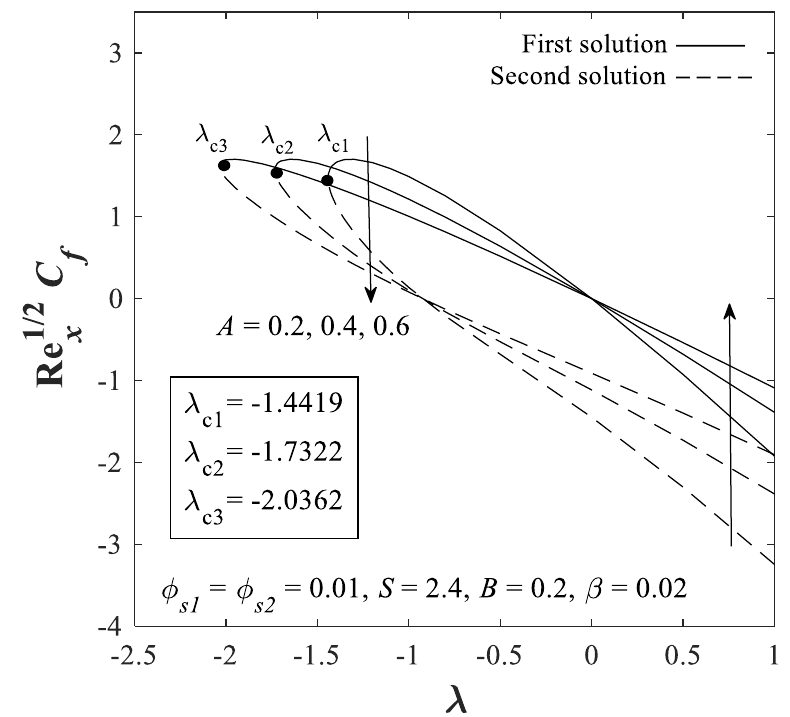
Figure 2. Plot of Re 1/2 x C f with λ for varied A C with λ for varied A . Figure 2. Plot of 1/2 Re x f